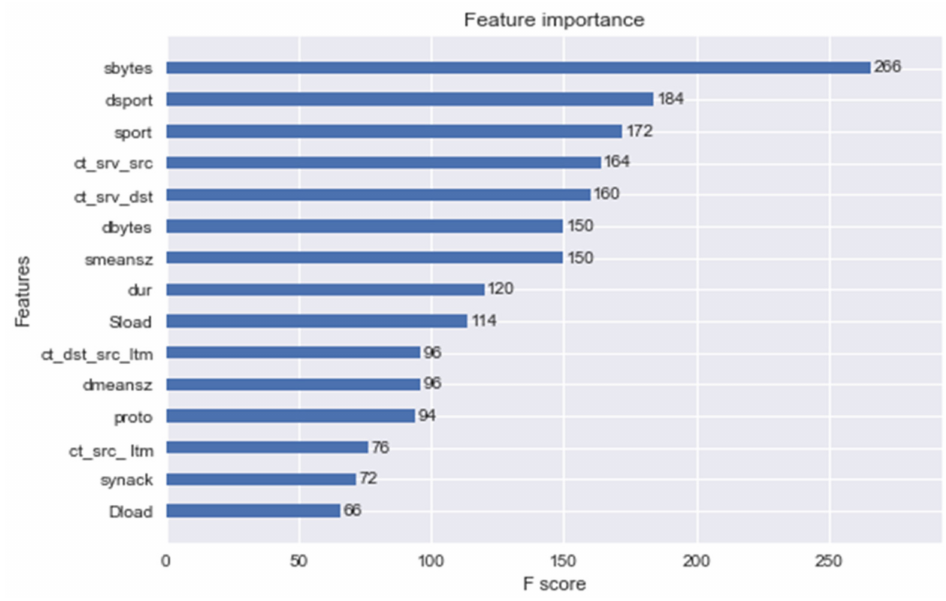
Figure 2. Feature importance generated by XGBoost.